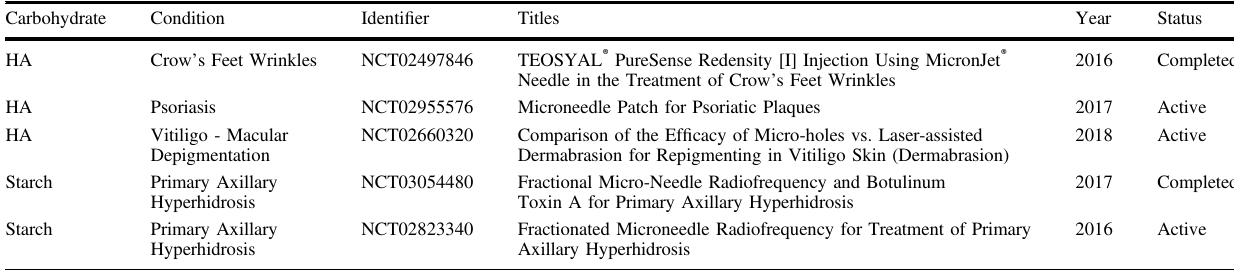
Table 6 list of active and completed clinical trials [91] Carbohydrate Condition